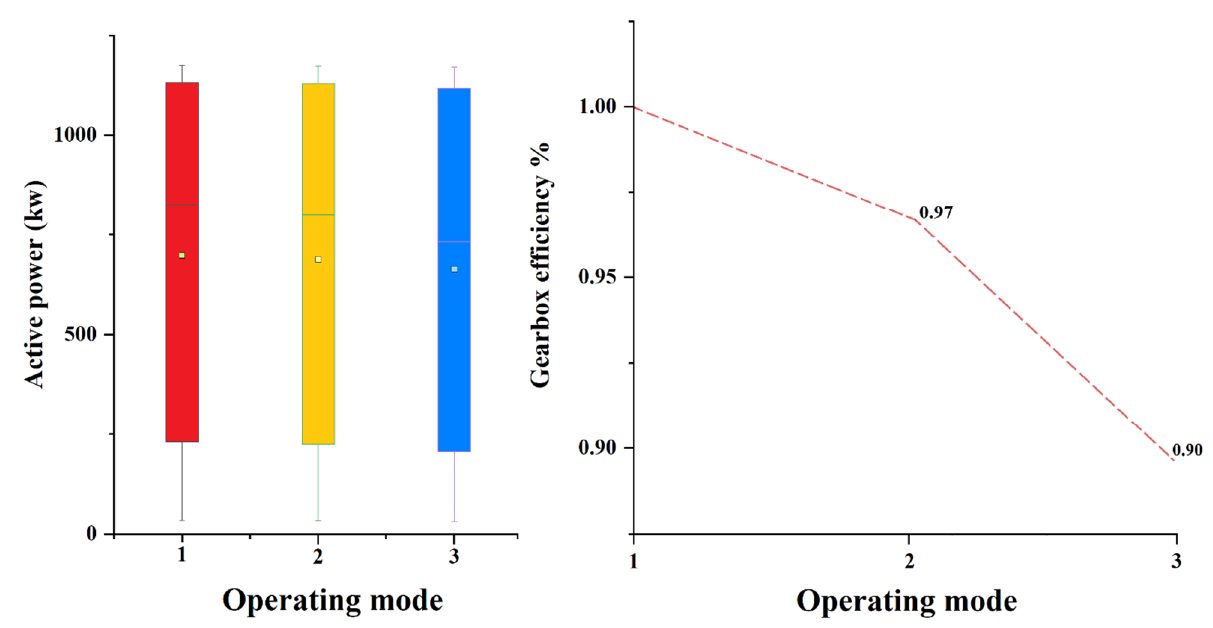
Figure 4. Gearbox efficiency degradation levels and Box plot of the simulated generated power for different operating modes.